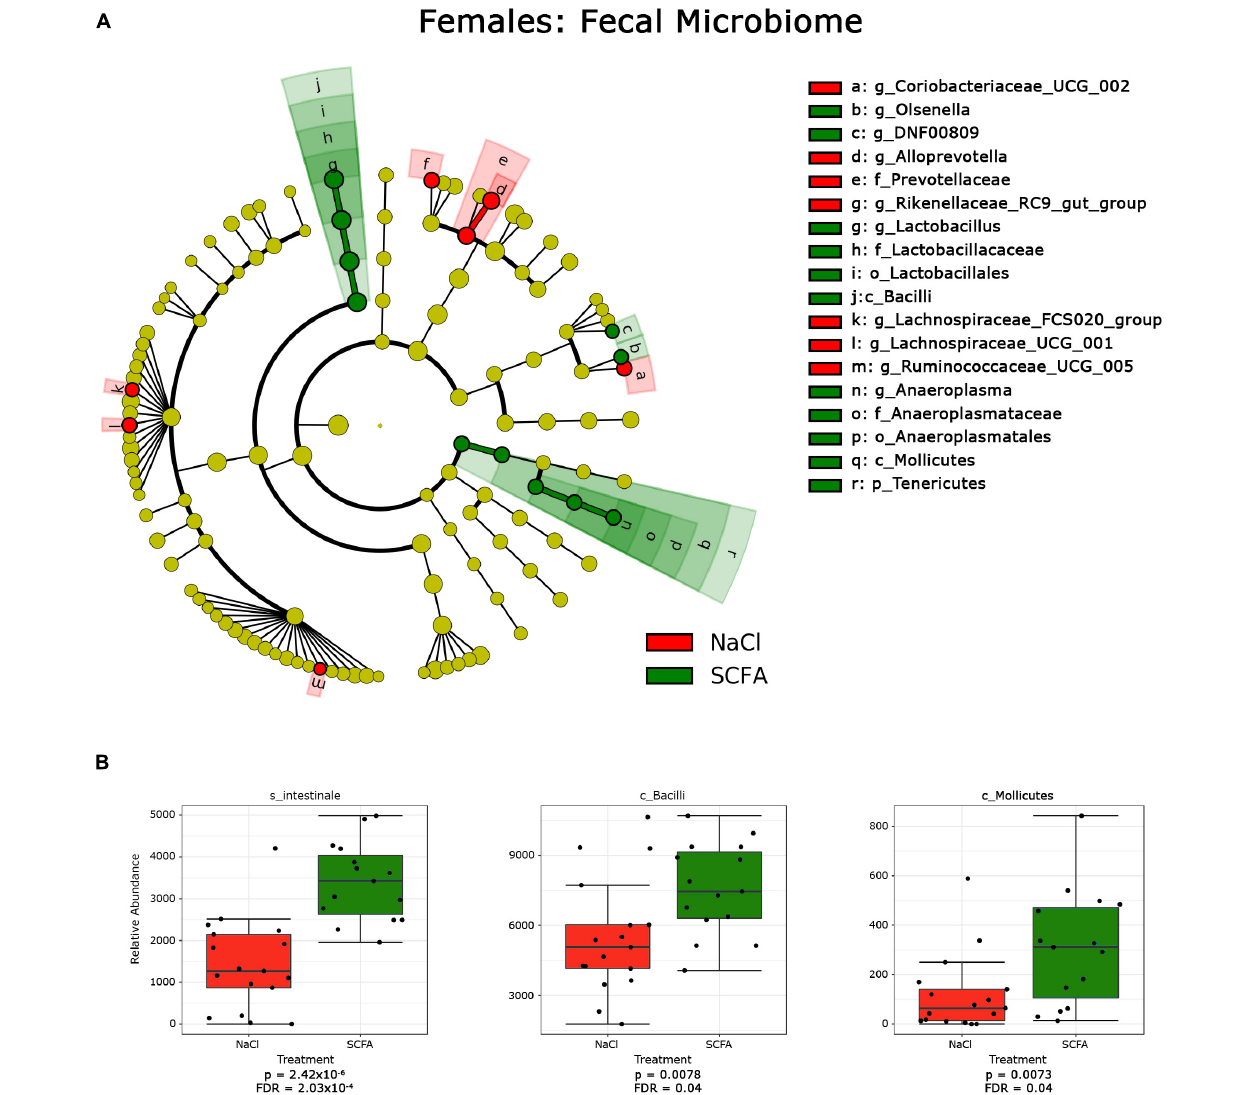
FIGURE 4 | Cladograms and box plots of individual taxa reveal microbial phylogenetic branches associated with short chain fatty acid (SCFA) supplementation in female mice. (A) Statistical significance reflects both p < 0.05 for Kruskal-Wallis tests and a logarithmic LDA score > 2.0. (B) Box plots present the relative abundance of individual taxa that are significantly associated with SCFA supplementation by classical univariate analysis. A full list of taxa with nominal p-values and FDR corrected p -values is provided in Supplementary Material 1.1–1.6